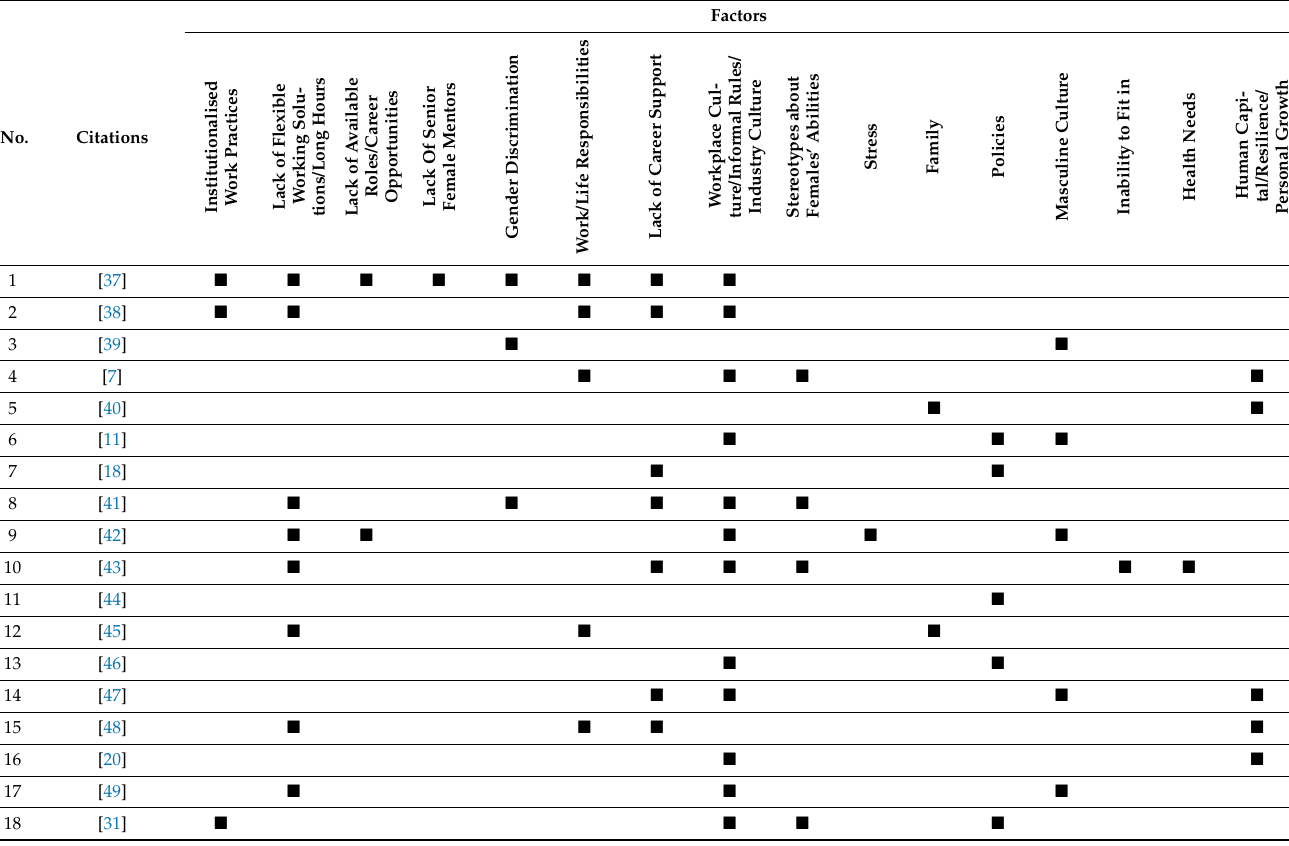
Table 3. Mapping the challenges affecting women in the Australian construction industry in the literature